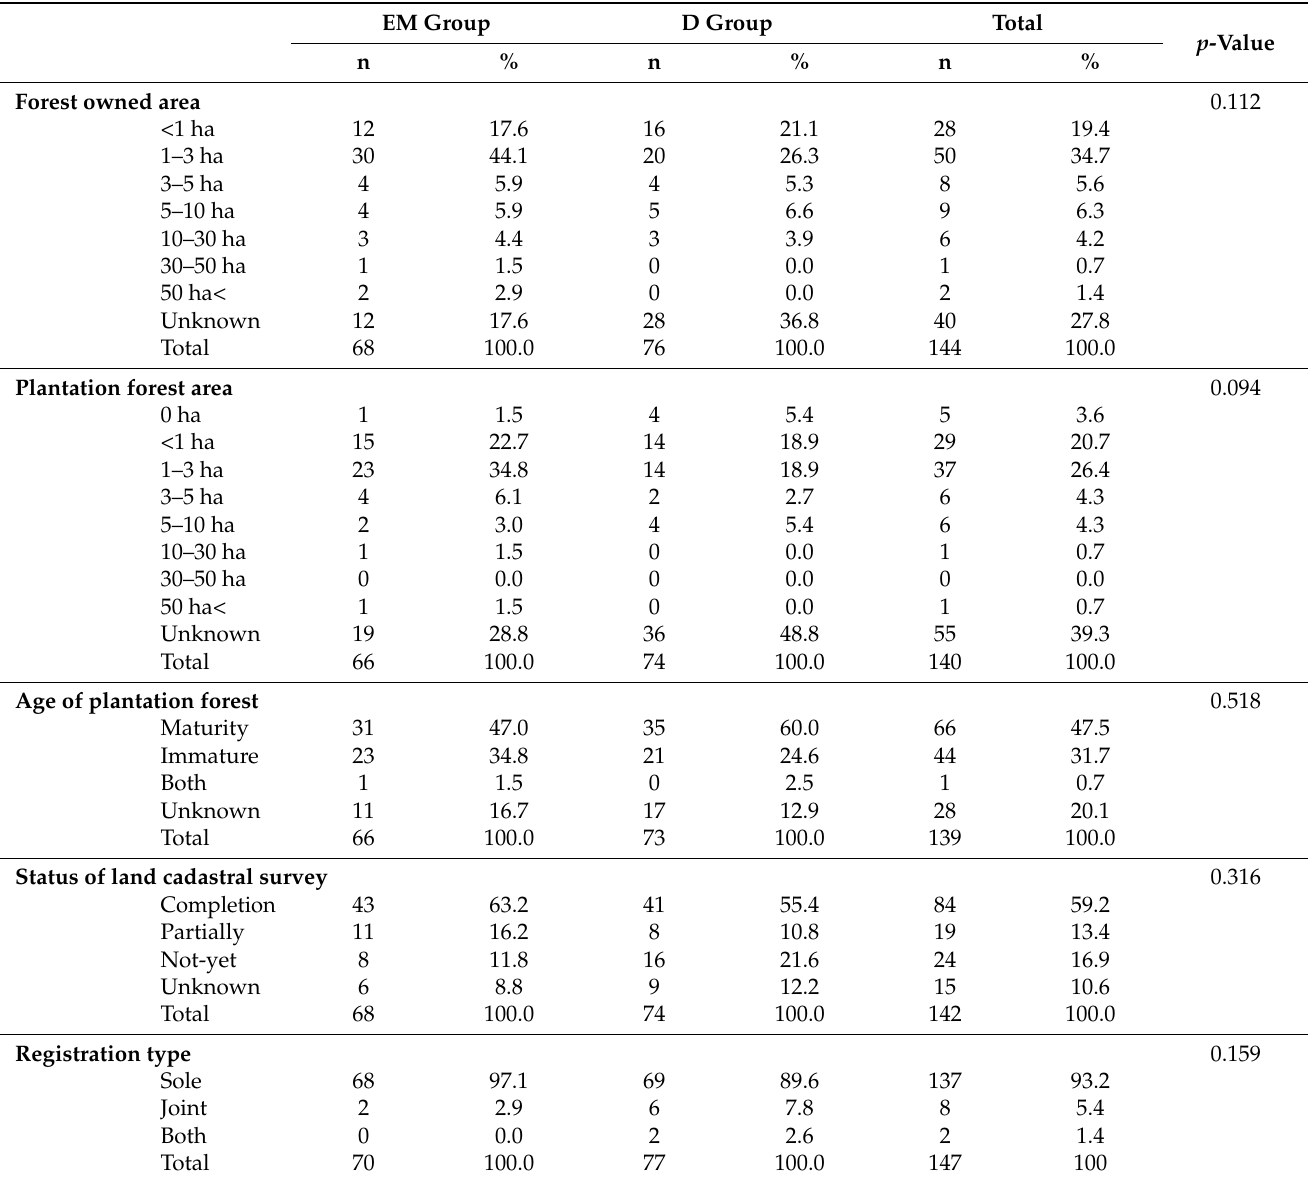
Table 4. Comparison of forest conditions between the two groups in